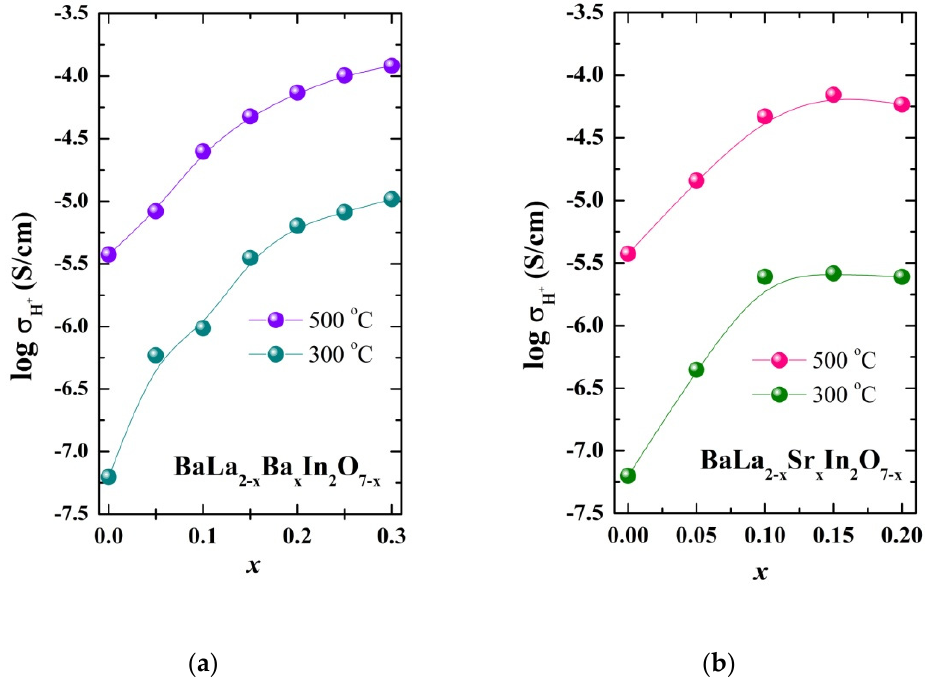
Figure 9. The concentration dependencies of proton conductivity at 500 and 300 °C for the solid solutions BaLa 2 − x Ba x In 2 O 7 − 0.5 x ( a ) and BaLa 2 − x Sr x In 2 O 7 − 0.5 x ( b ).